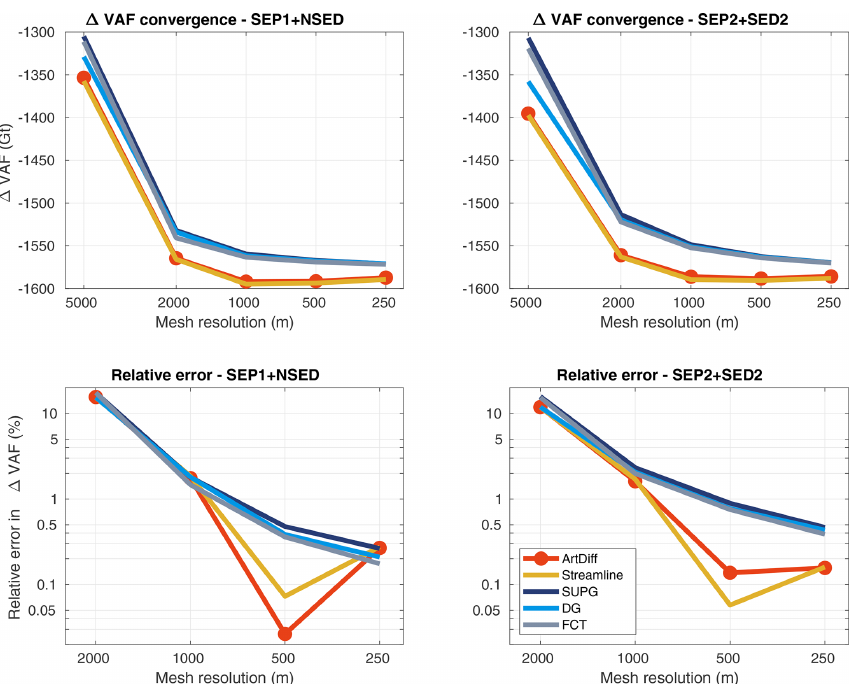
Figure 13. Basal friction perturbation experiment: convergence of (cid:49) VAF at the end of the experiment ( t = 100 years) for different stabiliza- tion schemes (see legend). Two sets of sub-element parameterizations are employed: SEP1 + NSED (left panels) and SEP2 + SED2 (right panels). The relative errors are computed using Eq. (45).